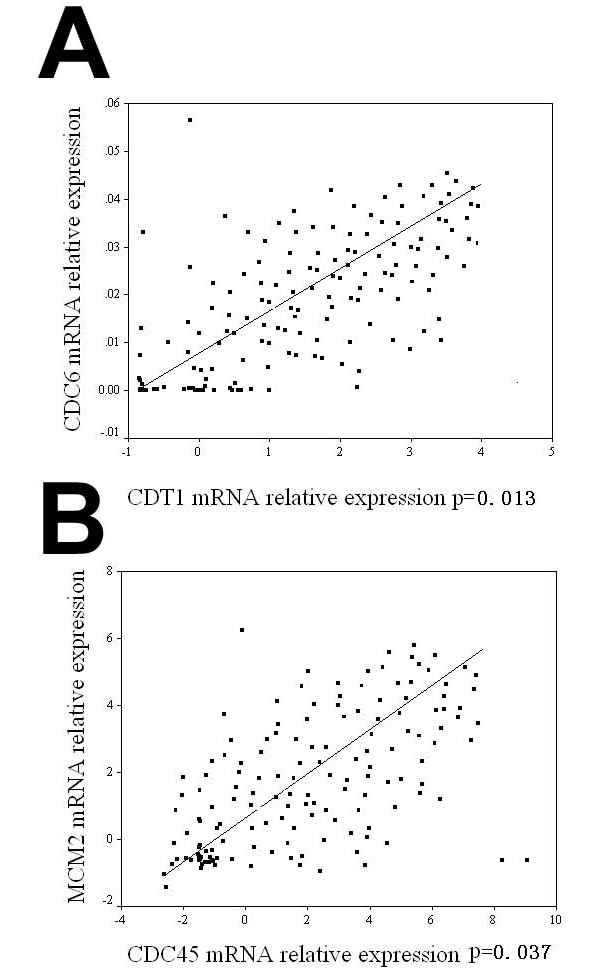
Relationship between the expression of CDC6 and CDT1 (A), and of CDC45 and MCM2 (B) in dysplasia and tongue SCC. The scatterplots suggested that the relationship could be modeled as linear. A significant correlation was observed (p = 0.013 and P = 0.037 respectively).